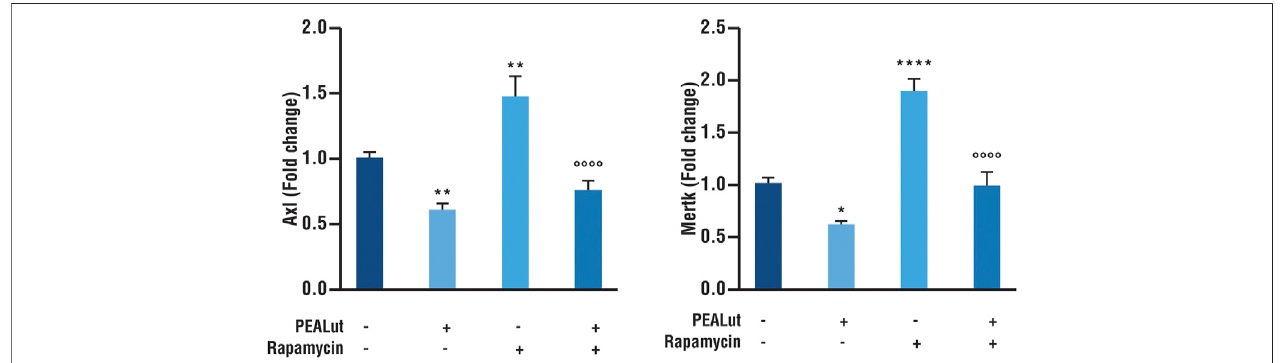
FIGURE4| PEALutreversedtherapamycin-inducedincreasesinAxlandMertkmRNAinOPCsatDIV8.CulturesofOPCsweretreatedwith10 μ MPEALutatDIV 2inculturesandprocessedatDIV8forreal-timePCR.Rapamycinwasadded30 minbeforePEALut.Dataareexpressedasmean ± SEM.Datawereanalyzedwithone- way ANOVA followed by post hoc Holm-Sidak ’ s multiple comparison test. Data were obtained from four separated experiments (12 values) Axl: ** p < 0.005 vs Vehicle; °°°° p < 0.0001 vs Rapamycin. Mertk: * p < 0.05 vs Vehicle; **** p < 0.0001 vs Vehicle; °°°° p < 0.0001 vs Rapamycin.